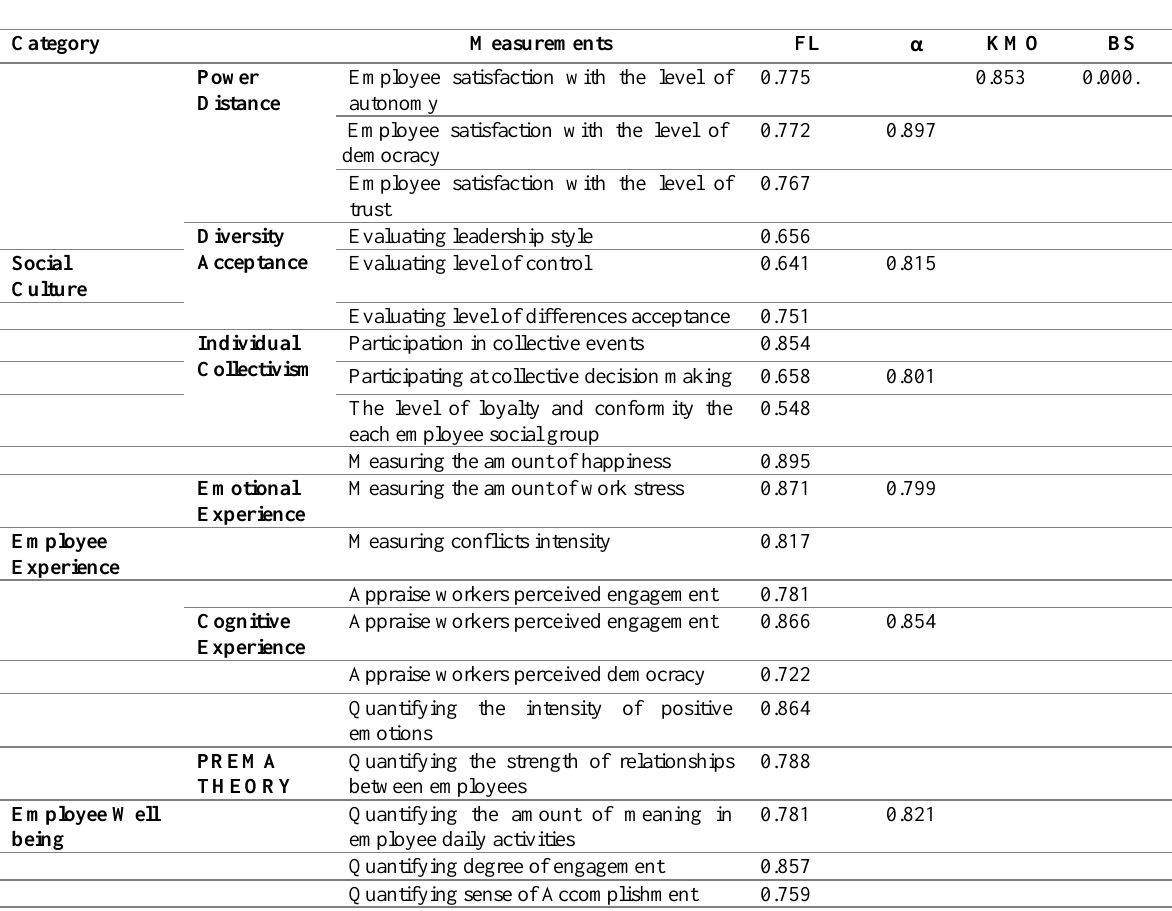
Table 2: Exploratory and reliability factor analysis